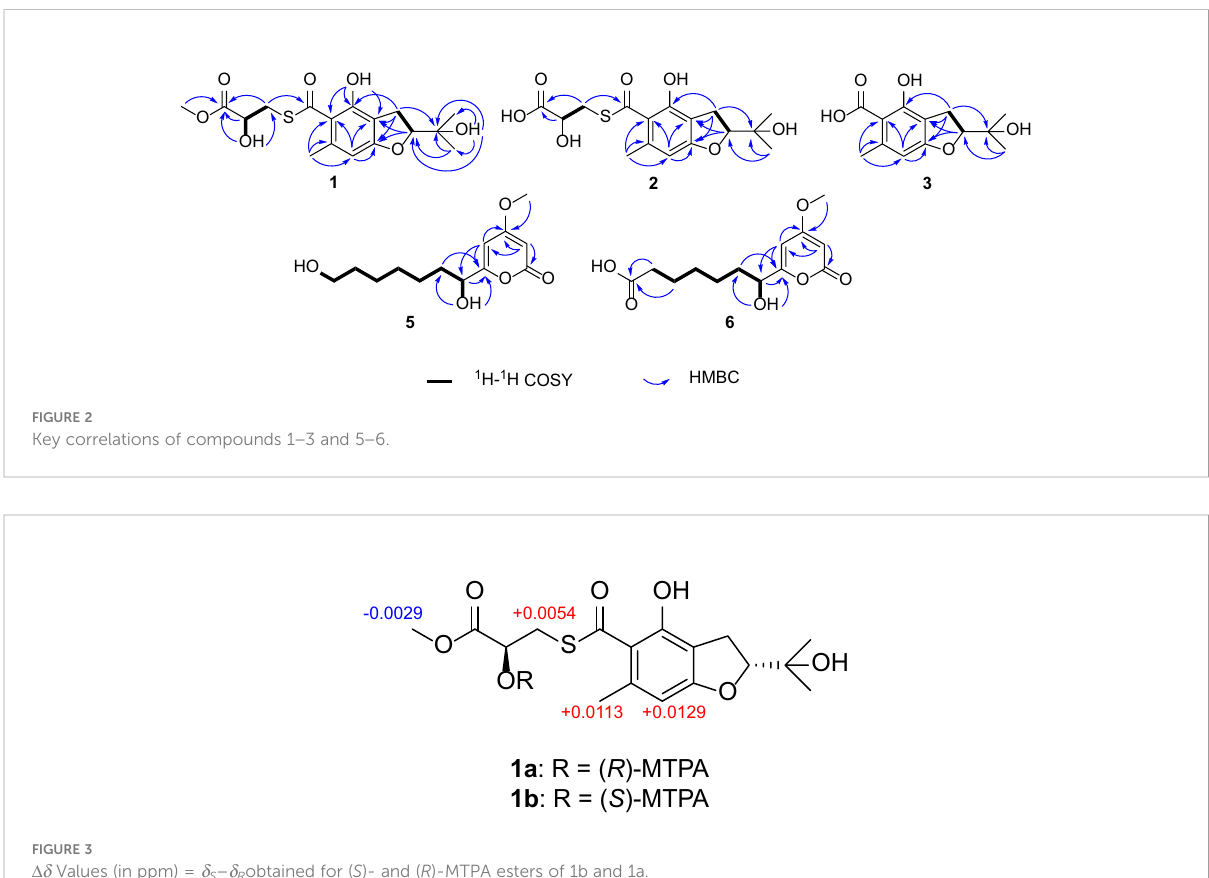
FIGURE 3 D d Values (in ppm) = d S – d R obtained for ( S )- and ( R )-MTPA esters of 1b and